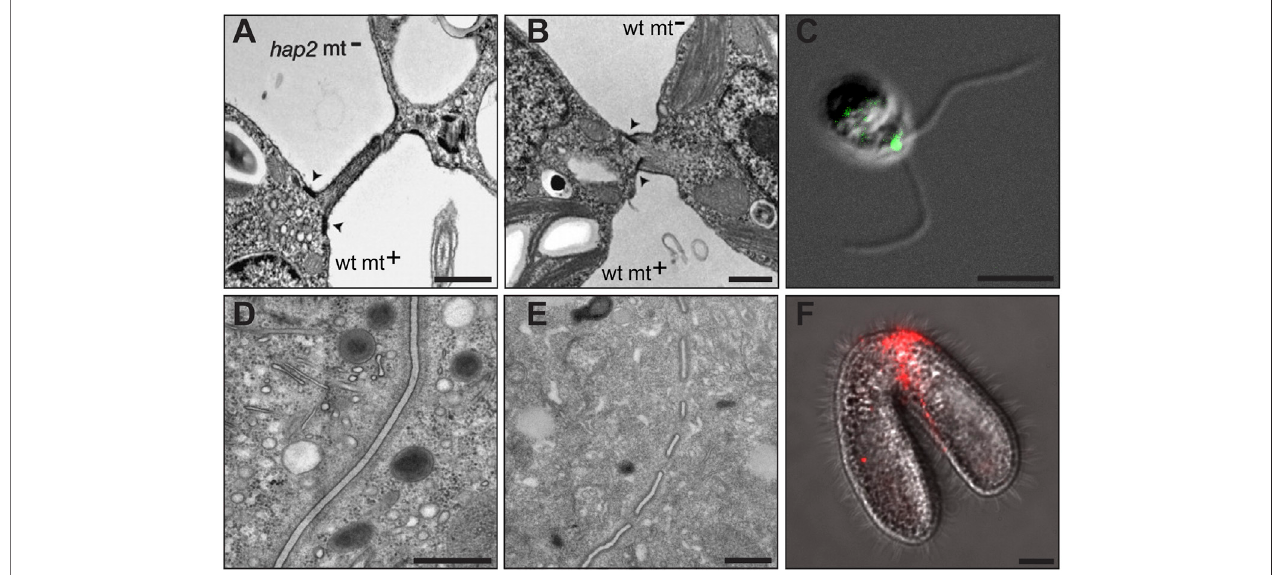
FIGURE 2 | HAP2-mediated membrane fusion in Chlamydomonas (A – C) and Tetrahymena (D – F) *. (A) A transmission electron micrograph (TEM) of Chlamydomonas gametes showing the adhering mating structures between a minus gamete in which the HAP2 gene was disrupted ( hap2 mt − ) and a wild type plus gamete (wt mt+). Arrowheads point tothe electron dense doublet regions at the base of the plus gamete mating structure. Minus gametes lacking HAP2 adhereto plus gametes by the tips of their mating structures but fail to fuse. (B) A TEM of wild type Chlamydomonas plus and minus mating structures immediately after membranefusionoccurs.Thefusionporecontinuestoexpandgivingwaytoasinglecontinuousmembranesurroundingzygote. (C) Animmuno fl uorescenceimageofa Chlamydomonas minus gamete showing a green punctum where HA-tagged HAP2 protein localizes between the two cilia, the site of the minus mating structure. (D) A TEMshowingmembranesattheconjugationjunctionofa Tetrahymena matingpairinwhichbothcellshavethe HAP2 genedeleted andareunabletoformfusionpores. Notethecontinuousmembranesinthecenteroftheimageextendingfromtoptobottom. (E) ATEMshowingmultiplemembranefusionporesattheconjugationjunction ofawildtypematingpairof Tetrahymena cells.Inwildtypepairs,numerouspores,orinterruptionsarepresentalongthelengthofthejunctionalmembranesthatcontinue to expand, but never extend beyond the junction itself and are eventually repaired at the conclusion of mating to allow cells to separate. (F) An immuno fl uorescence imageofa Tetrahymena matingpairshowingaredbandofsignalwhereHA-taggedHAP2proteinlocalizestotheconjugationjunctionbetweenthetwomatingcells,the site of membrane fusion pore formation. Scale bars are 200 nM (A – B) , 5 μ Mb (C) , 500 nM (D-E) , and 10 μ M (D) . *TEMs of interacting Chlamydomonas gametes, originally published by Liu et al. in Genes & Development 2008 Apr 15; 22(8):1,051-68 (DOI: 10.1101/gad.1656508) were adapted for this fi gure and are used here with permission from the authors under license # CC-BY-NC 4.0. TEMs and immuno fl uorescence image of mating Tetrahymena cells, originally published by Cole et al. in Current Biology 2014 Sep 22; 24(18):2,168 – 2,173 (DOI: 10.1016/j.cub.2014.07.064) were adapted for this fi gure and are used here with the permission of the